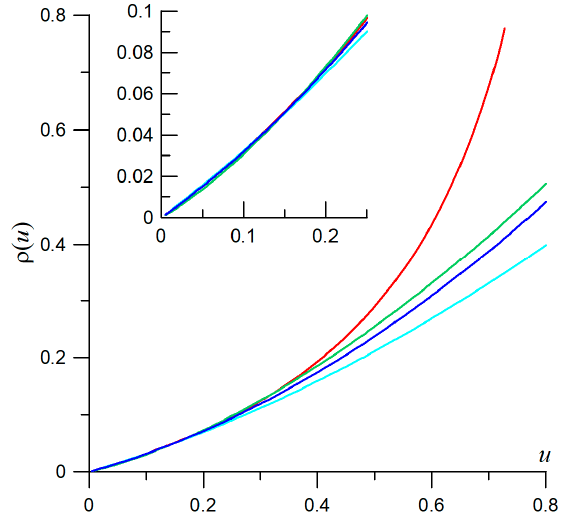
Figure 13. Functions ρ ( λ ) according to Equations (7)–(10). Red line, Equation (7); Green, Equation (8); light blue, Equation (9); Blue, Equation (10).